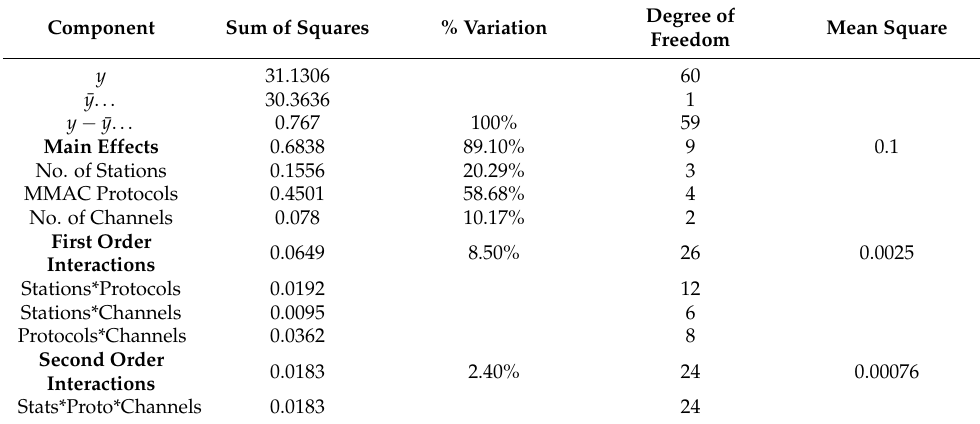
Table 7. ANOVA for Jain’s Fairness